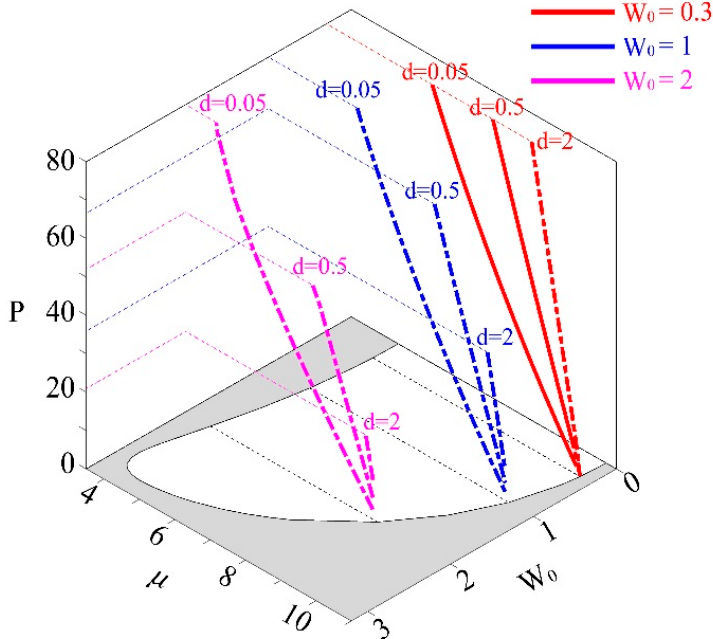
Figure 7. The power curves of six-pole solitons in PT-symmetric triangular lattices with different d and W 0 . The gray area in the µ –W 0 plane is the optical energy band of the triangular lattices, and the white area is the first bandgap. The solid lines correspond to the stable solitons, while the dashed lines correspond to the unstable ones.